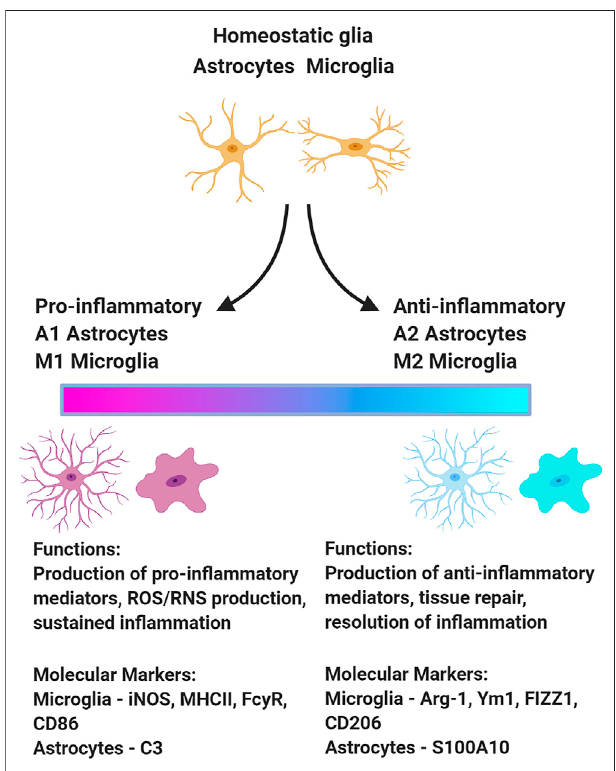
FIGURE 1 | Upon insult, microglia and astrocytes can adopt a variety of phenotypes associated with different functions. This schematic presents one modelofthefunctionalpolarizationofmicrogliaandastrocytesfollowingacute OP intoxication illustrating a continuum from the extreme pro- in fl ammatorytoanti-in fl ammatorystate.Thereissomeevidenceofphenotypic diversity of microglia and astrocytes in animal models of acute OP intoxication (Maupu et al., 2021). Figure created with